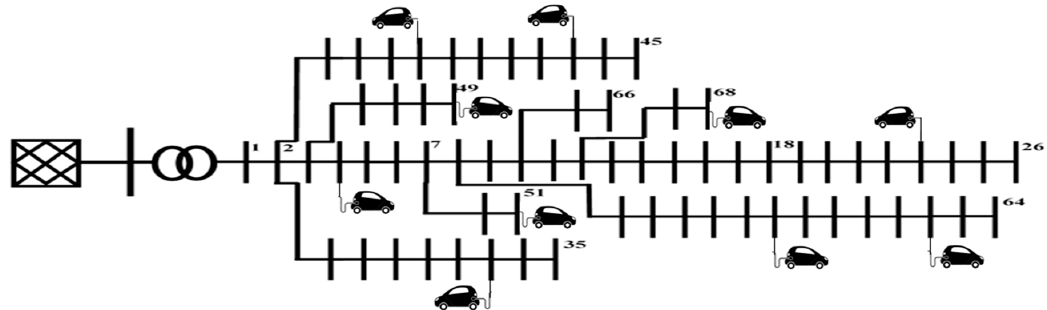
Figure 4. One-line diagram of the IEEE 69 radial distribution test system.